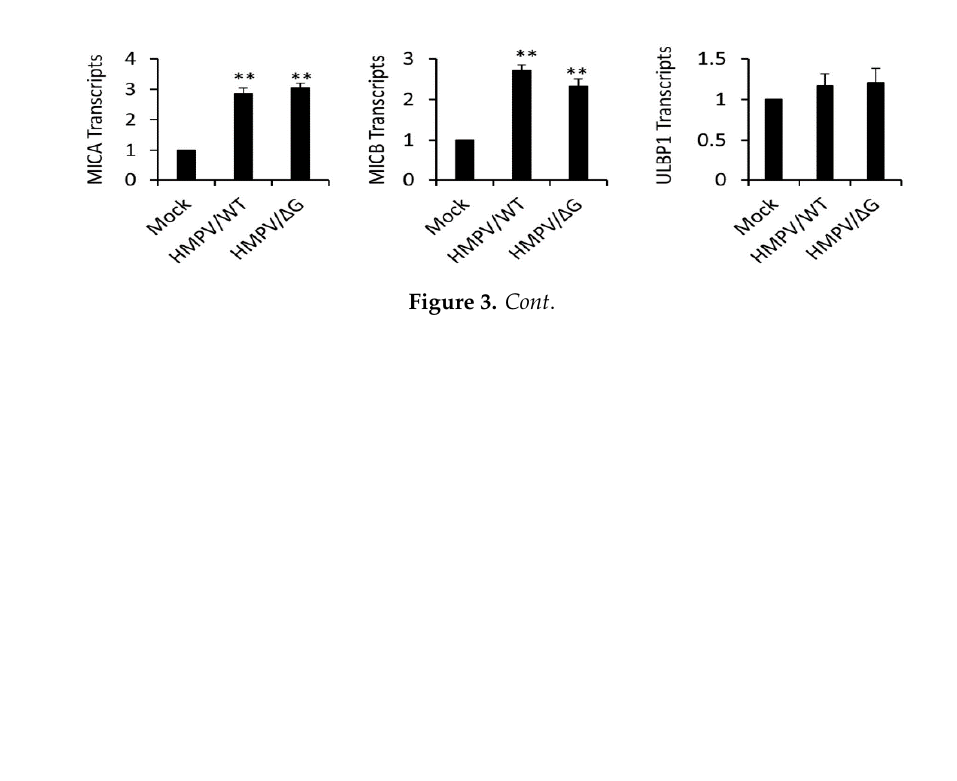
Figure 3. HMPV-infected A549 cells upregulate mRNA levels of natural killer group 2D (NKG2D) ligands. ( A – E ) Real Time PCR quantification of NKG2D ligands, major histocompatibility complex (MHC) class I polypeptide-related sequences A and B (MICA) ( A ), (MICB) ( B ), UL16 binding proteins (ULBP1) ( C ), (ULBP2) ( D ), and (ULBP3) ( E ) expression in mock-infected A549 cells (Mock), HMPV/WT-infected A549 cells (HMPV/WT), and HMPV/∆G - infected A549 cells (HMPV/∆G).